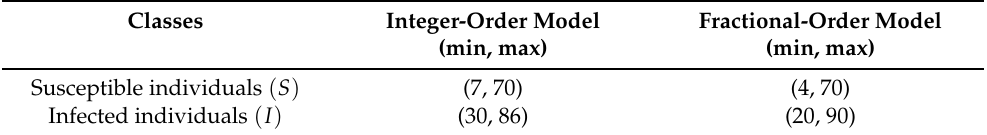
Table 1. The minimum and maximum numbers of expected cases for the susceptible class and infected